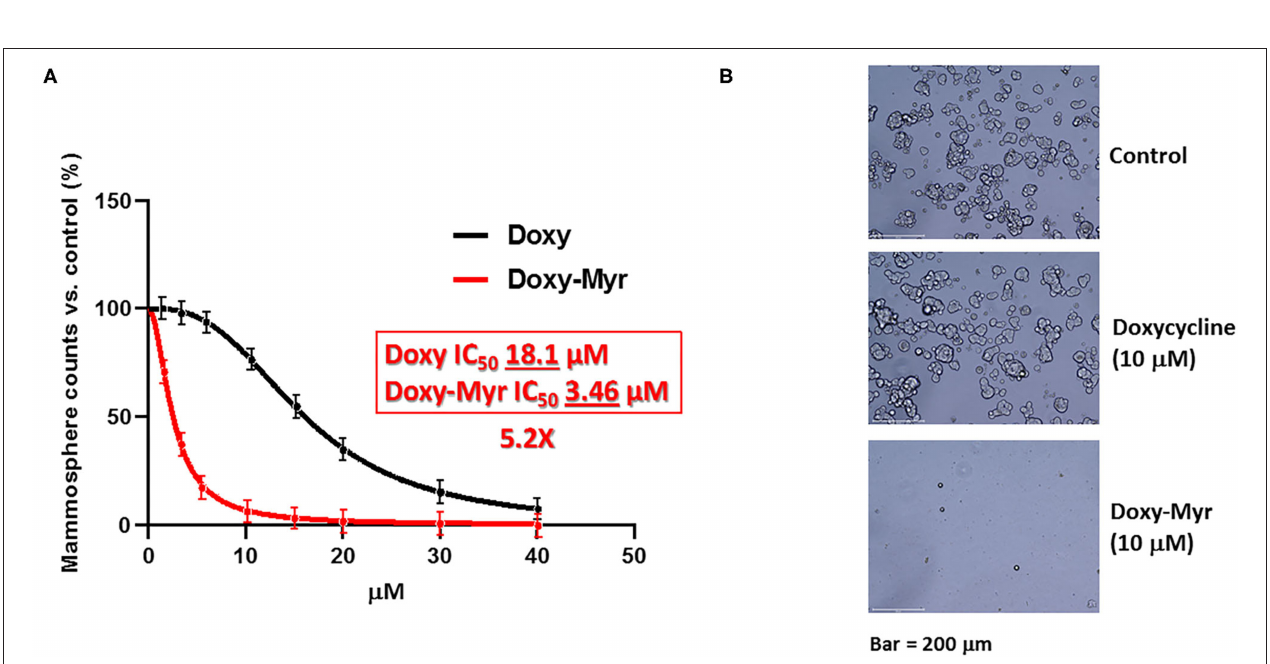
FIGURE 2 | Doxy-Myr more potently inhibits the anchorage-independent propagation of CSCs. (A) MCF7 cells were plated under anchorage-independent growth conditions and the number of 3D-mammospheres were counted after 5 days. Note that Doxycycline and Doxy-Myr both inhibited 3D-mammosphere formation, all relative to vehicle-alone controls. However, Doxy-Myr was > 5-fold more potent than Doxycycline (IC-50 of 3.46 vs. 18.1 µ M). (B) Representative phase images of 3D-mammospheres are shown. Bar = 200 µ m.